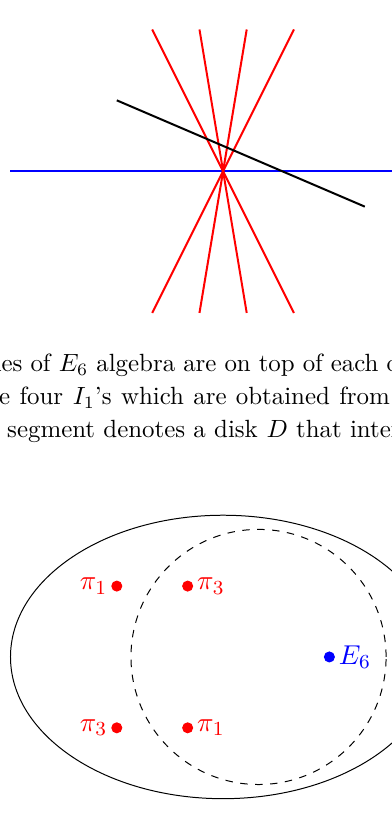
Figure 9 . On disk D there are four I 1 ’s and the E 6 gauge branes. The 10 branes enclosed by the dashed circle are { π which are the brane content of an E 1 , π 3 , π 1 , π 3 , π 1 , π 3 , π 1 , π 3 , π 1 , π 3 } 8